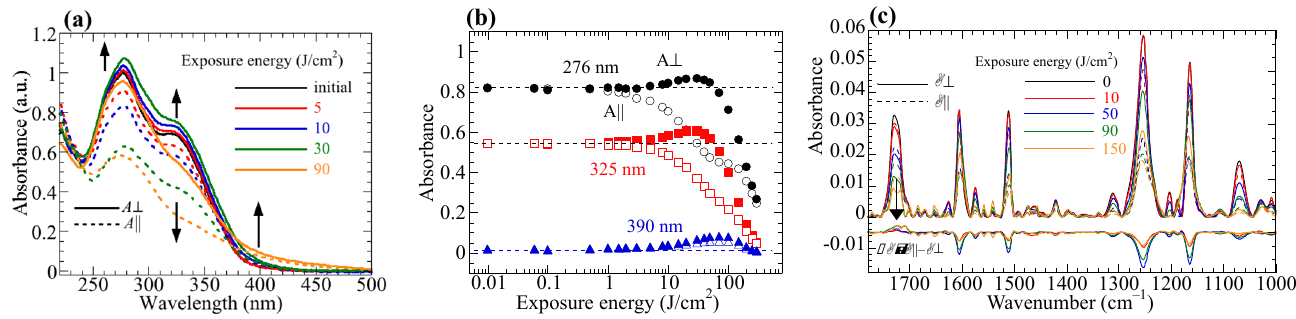
Figure 2. ( a ) Change in the polarized absorption spectra of a P4 film, ( b ) absorbances of a P4 film as a function of exposure dose, and ( c ) change in the polarized FTIR spectra of a P4 film, exposed to linearly polarized 313 nm light.